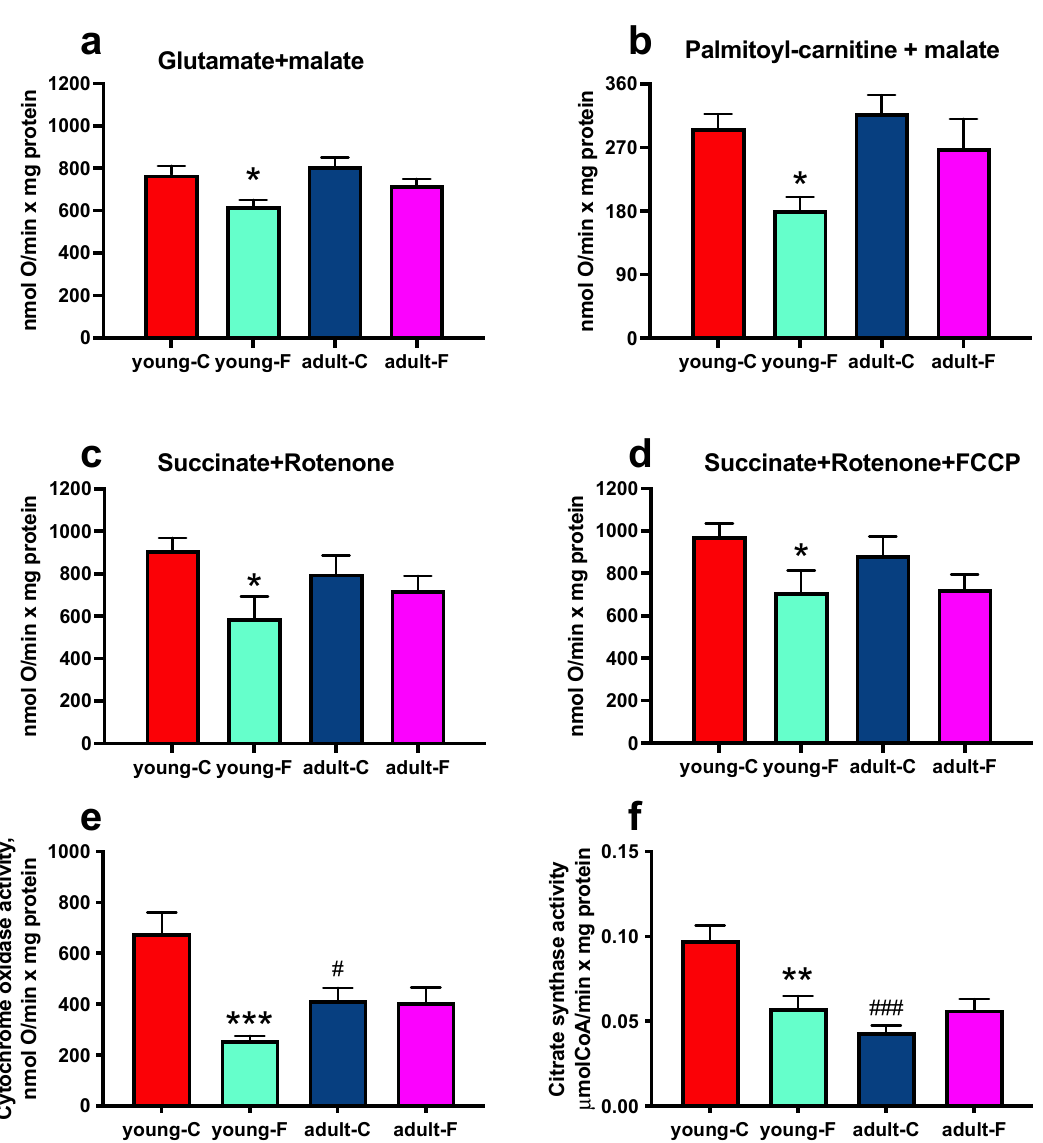
Figure 4. Mitochondrial markers. ( a – d ) Mitochondrial oxygen consumption and activities of ( e ) cytochrome oxidase and ( f ) citrate synthase measured in skeletal muscle isolated mitochondria of young and adult rats fed a control (young-C and adult-C) or fructose-rich diet (young-F and adult-F) for 2 weeks. Values are the means ± SEM of eight different rats. * p < 0.05, ** p < 0.01, *** p < 0.001 compared to respective controls; # p < 0.05, ### p < 0.001 compared to young-C rats (two-way ANOVA followed by Tukey post-test).